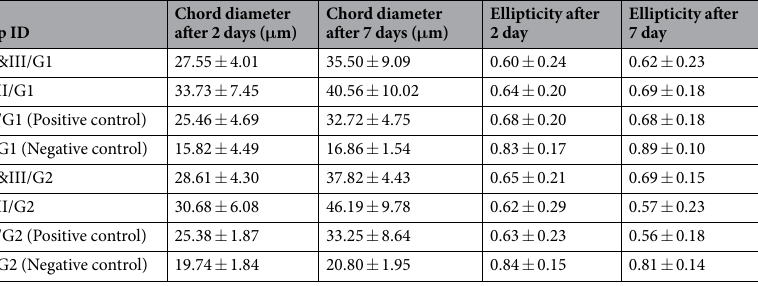
Table 3. Morphology data. Chord diameters ( μ m) and cell ellipticity were measured for cells encapsulated in the hydrogels after 2 and 7 days in culture. Mean ± standard deviation of the data is listed (Col-I: collagen type I, Col-III: collagen type III and Col-I&III: the simultaneous presence of Col-I and Col-III; G1 and G2 represent 2% and 1% final glycol-chitosan concentration,